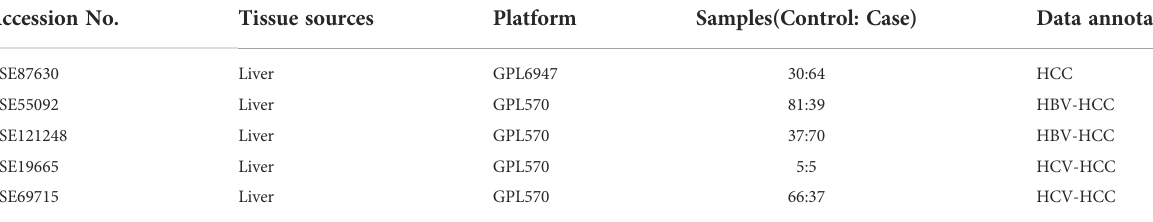
TABLE 1 The characteristics of the datasets used in the present study. Accession